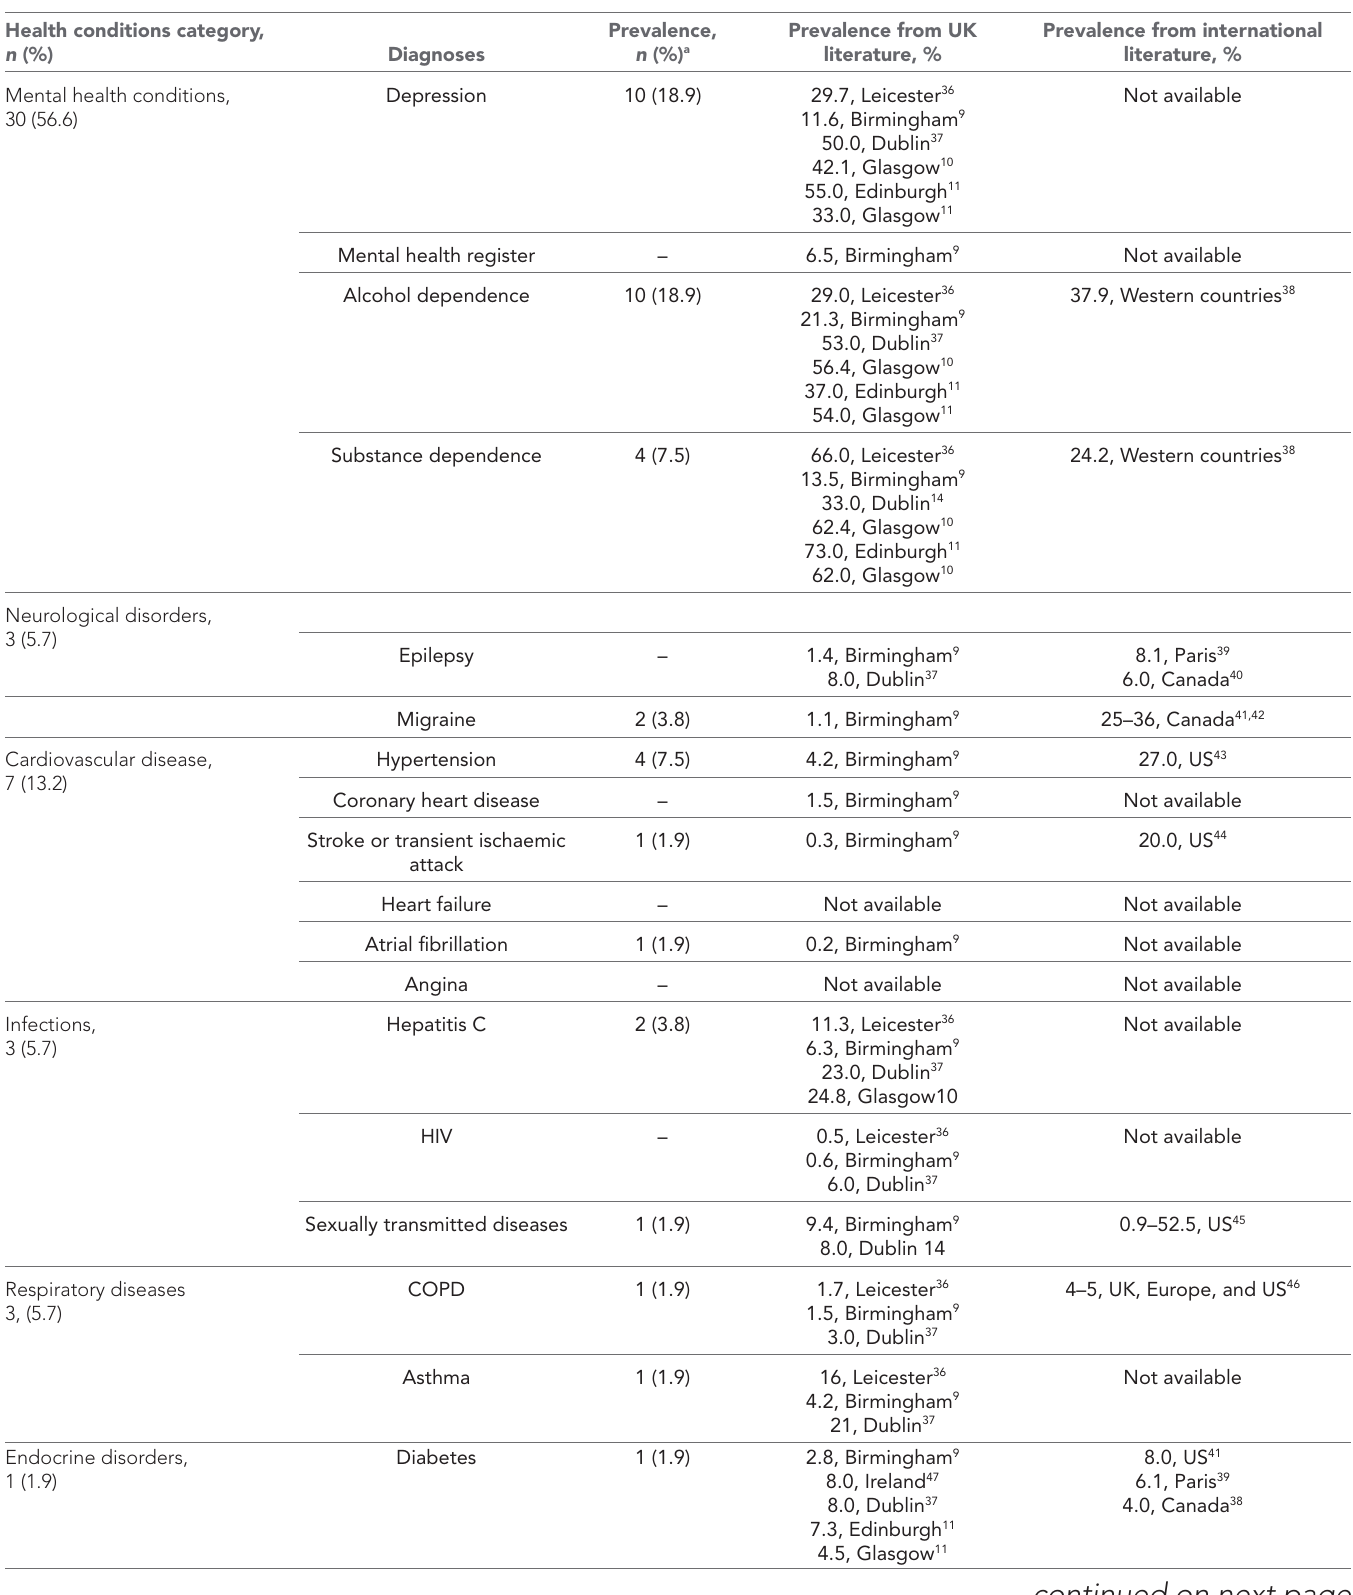
Prevalence, Prevalence from UK Prevalence from international literature, % literature, % n (%) a